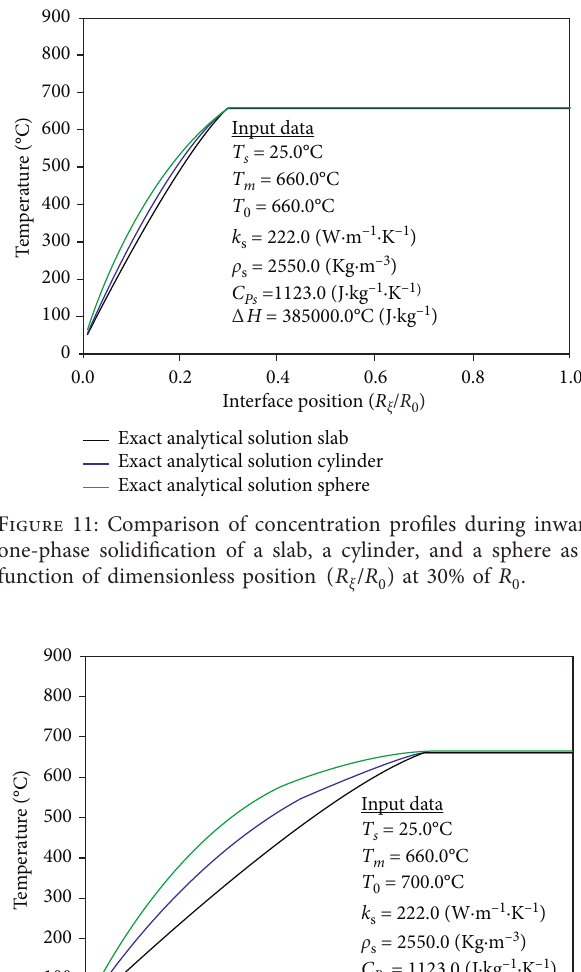
Figure 10: Comparison of concentration profiles during inward diffusion of a slab, a cylinder, and a sphere as a function of di- mensionless position ( R